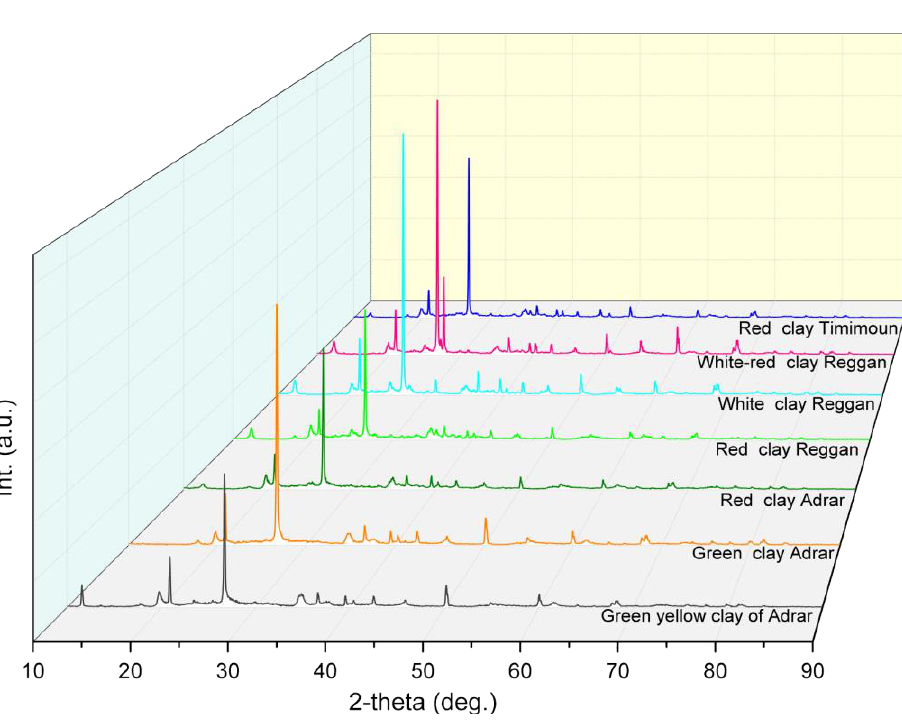
Figure 1. XRD patterns of the studied natural clay samples.